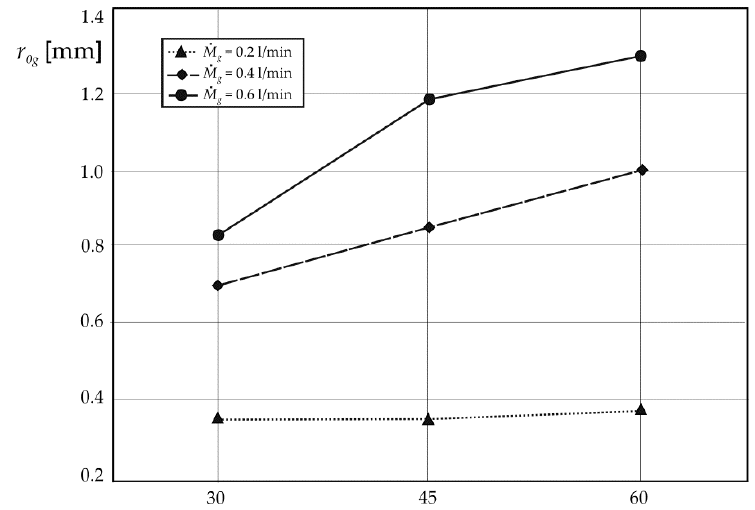
Figure 7. The relationship between the flow swirl insert and the diameter of the air core [85]. The authors of the work [45] conducted an in-depth analysis of the liquid flow struc- ture at the outlet opening of the atomizer. The atomization process was carried out for a single and two-phase system. Selected photographic images of the sprayed liquid for the air-water system are shown in Figure 8, and for the system of air-water glycerin solution with polymer addition in Figure 9.